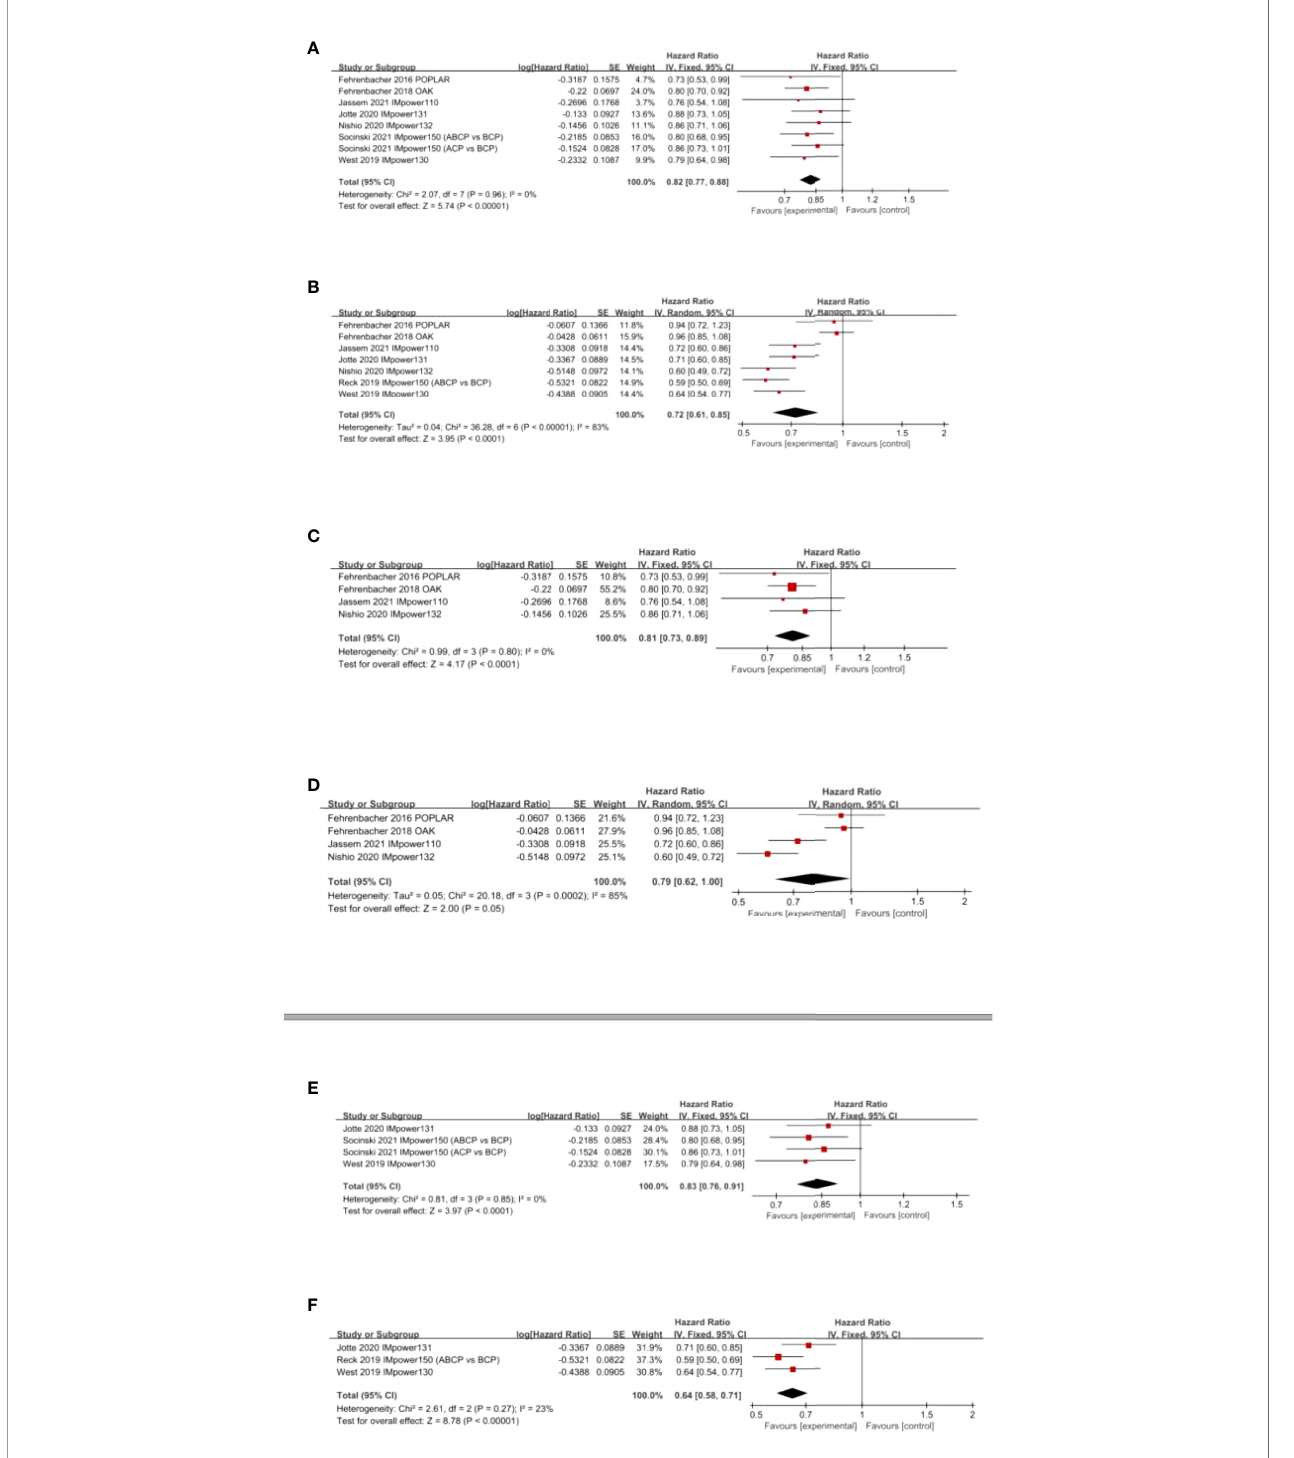
FIGURE 3 | Forest plots of HRs comparing (A) OS and (B) PFS between atezolizumab-based therapy and chemotherapy-based therapy, (C) OS and (D) PFS based on atezolizumab monotherapy, and (E) OS and (F) PFS based on atezolizumab combined